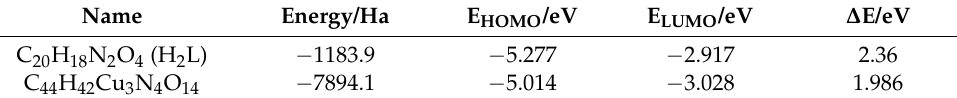
Figure 5. Surface plots of HOMO-LUMO of H 2 L (left) and its Cu II complex (right). Table 5. Frontier molecular orbital energies and molecule energies of H 2 L and its Cu II complex.